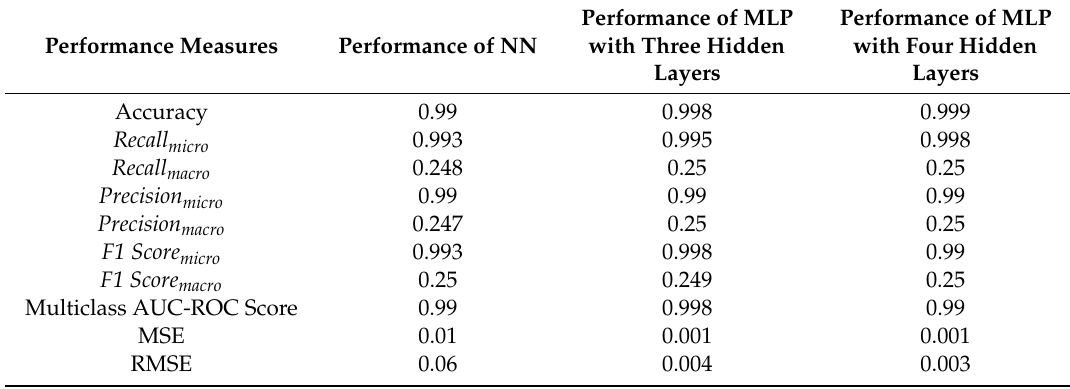
Table 6. Performance of NN and MLP with N h = 80 for multiclass classification averaged over ten independent